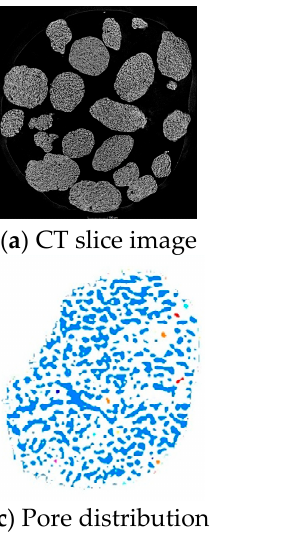
Figure 3. Nano-CT images of the AP pore structure.